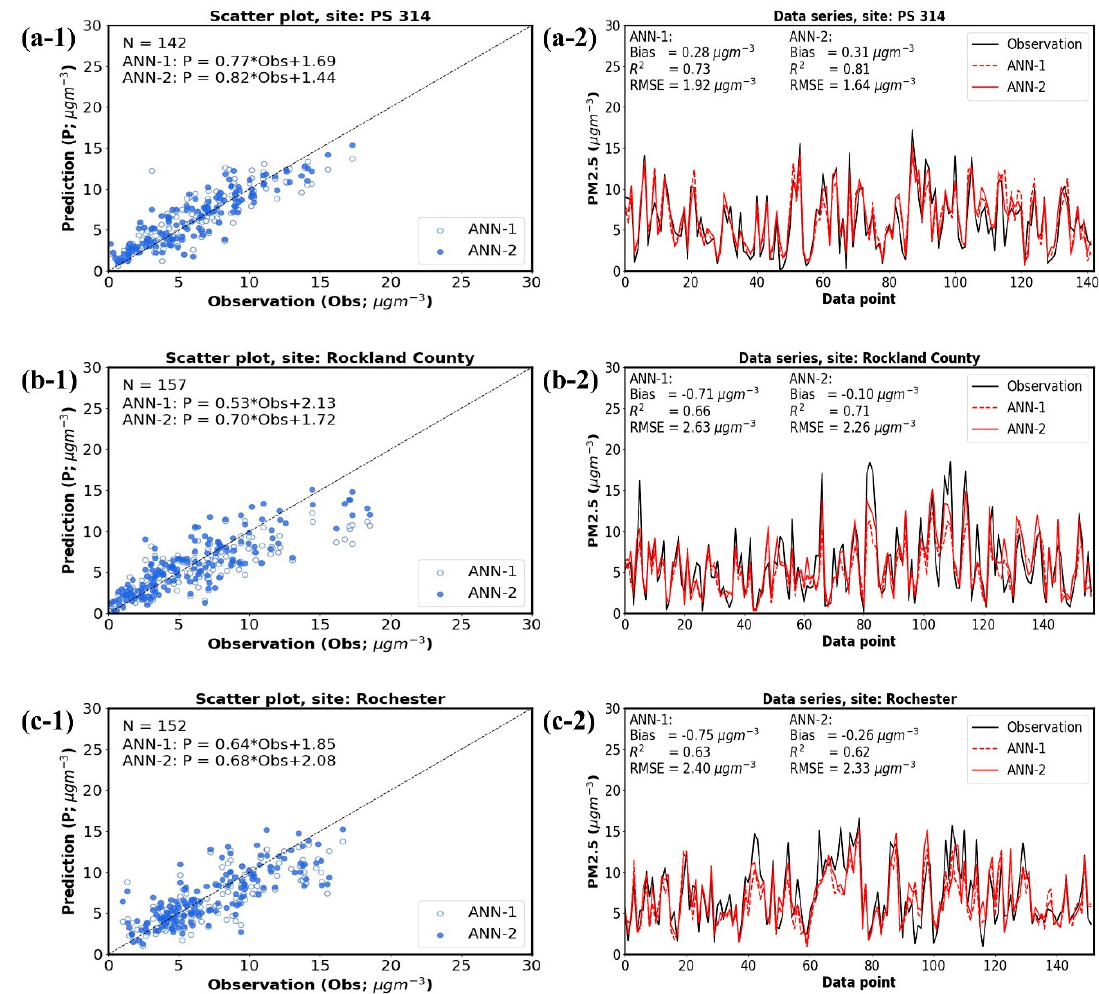
Figure 4. Scatter plots, with PM 2.5 observation as x-axis and prediction as y-axis, and data plots, with available data point as x-axis and PM 2.5 concentration as y-axis, of the testing results of the ANN models at ( a-1 , a-2 ) PS 314, ( b-1 , b-2 ) Rockland County and ( c-1 , c-2 ) Rochester sites. The data point in data plots are composited from four summers and each point represents one day.